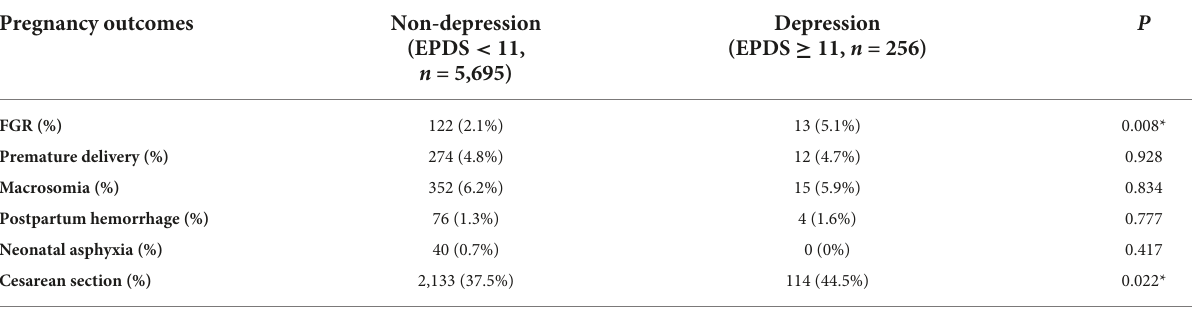
TABLE 3 The comparison of pregnancy outcomes between the two